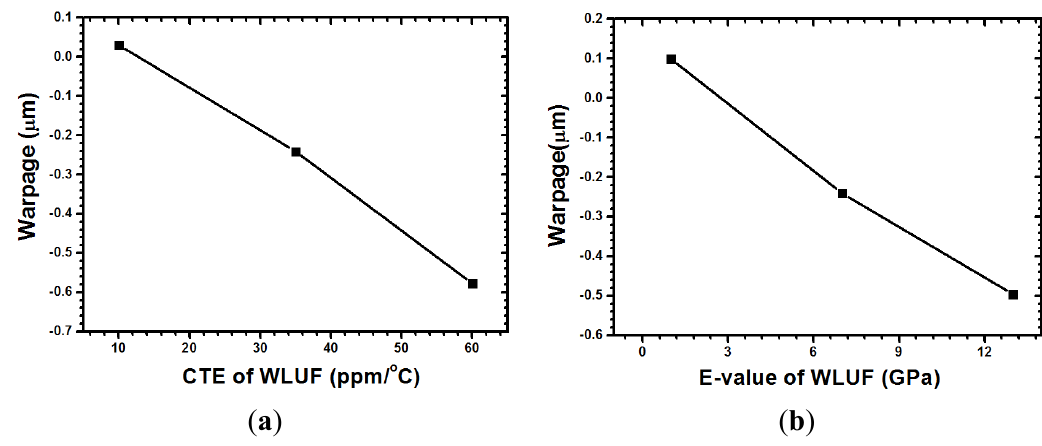
Figure 13. Plots of main effects with other factors fixed at middle level: ( a ) CTE of WLUF; ( b ) E -value of